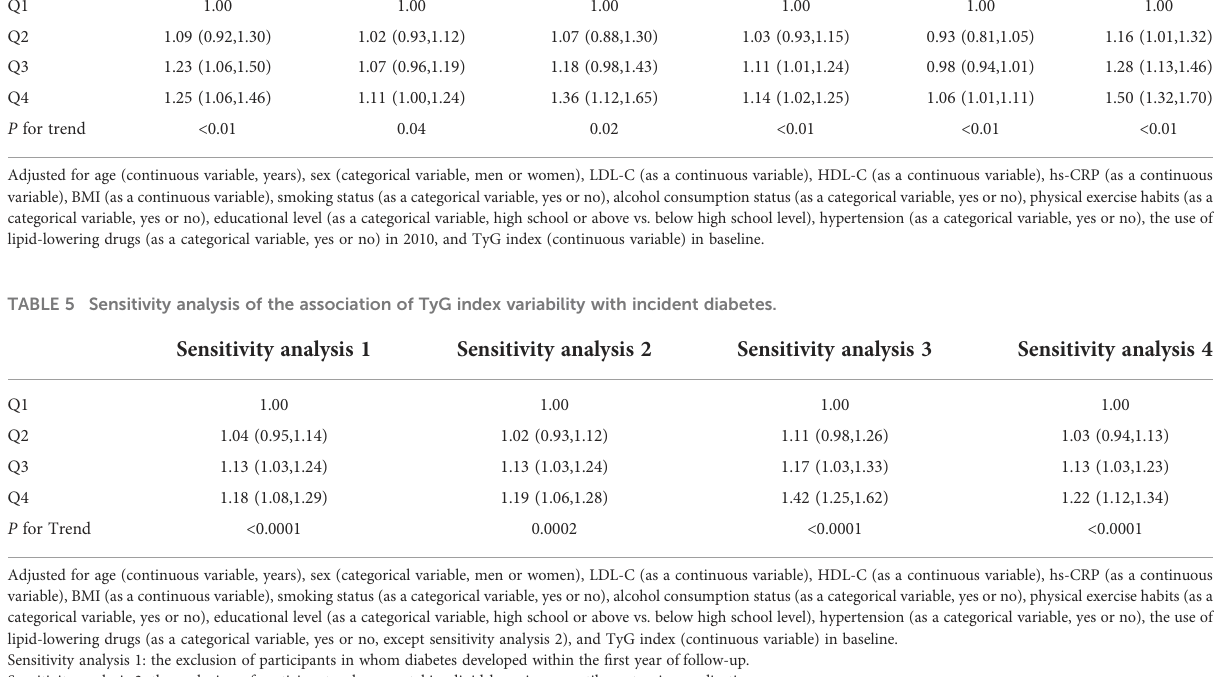
TABLE 4 Hazard ratios and 95% Con fi dence intervals of incident of TyG index in subgroup ratio variability (SD). Age ( P for interaction 0.33) Sex ( P for interaction 0.16) TyG index change slop <45 years ≥ 45 years